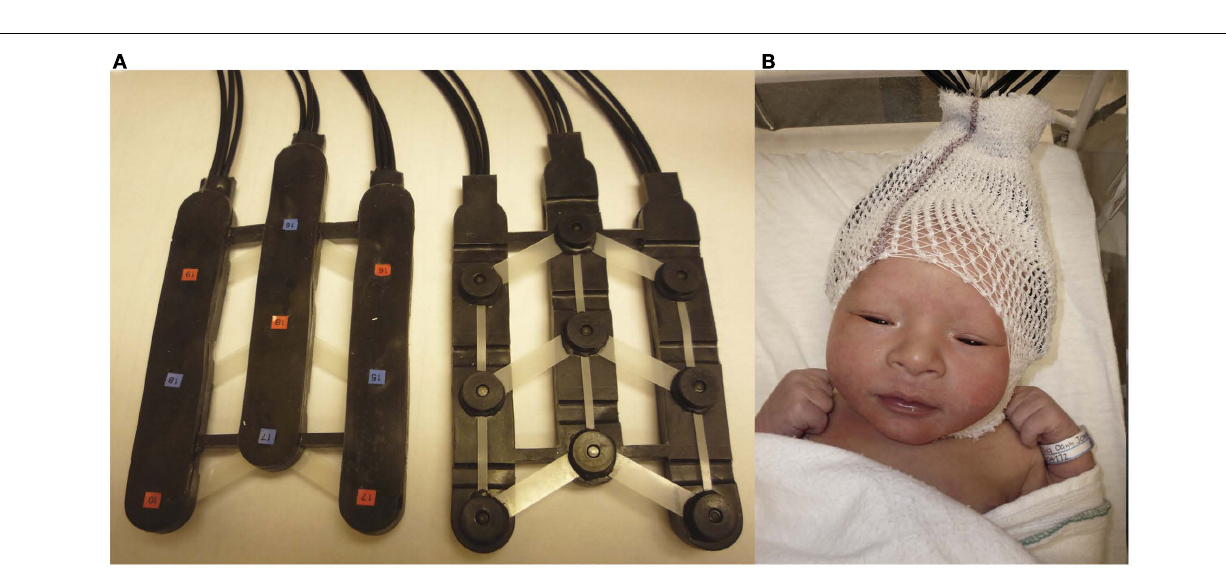
FIGURE 2 | (A) Picture of chevron-shaped probes used. (B) Picture of a neonate with probes placed upon the